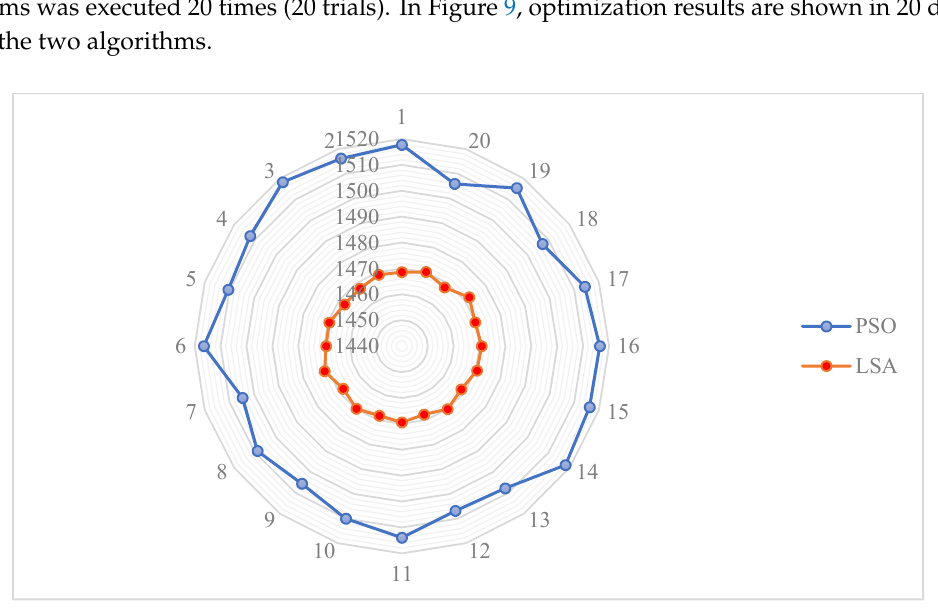
Figure 9. Optimization results of PSO and LSA in 20 trials.